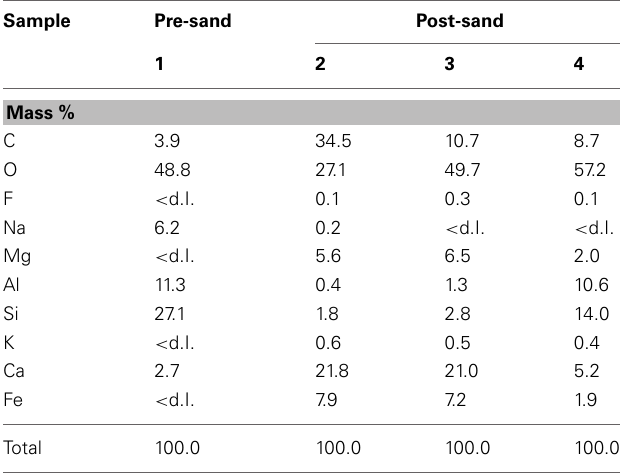
chlorite in samples pre-sand and post-sand.